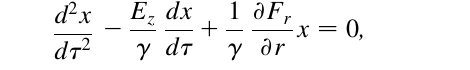
) and transverse ( F ) com- z r